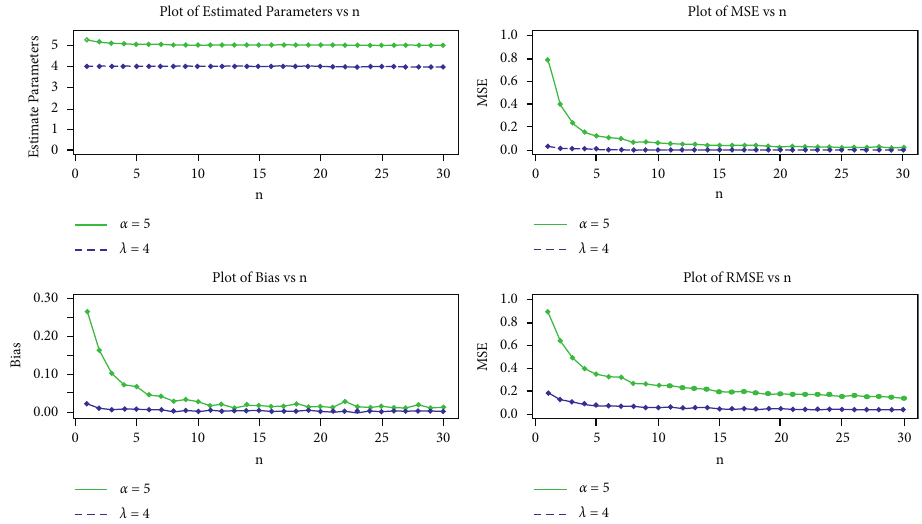
Figure 4: Visual representation of the MC simulation outcomes given in Table 2. Plot of Estimated Parameters vs n Plot of MSE vs n